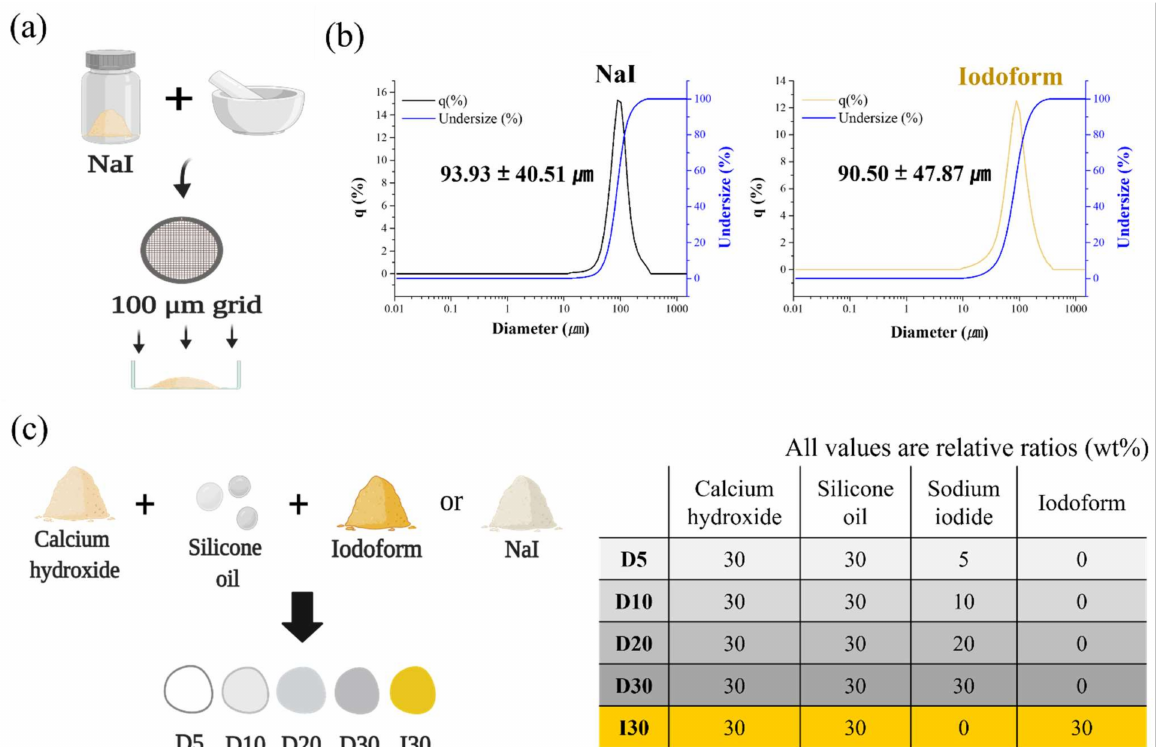
Figure 5. Development of NaI-incorporated paste (NaI@P). ( a ) Schematic illustration of the fabrication of strained NaI. ( b ) Graph comparing the particle size distribution of strained NaI and existing iodoform. ( c ) The composition of NaI-incorporated pastes (NaI@P) in a different proportions and iodoform-incorporated paste